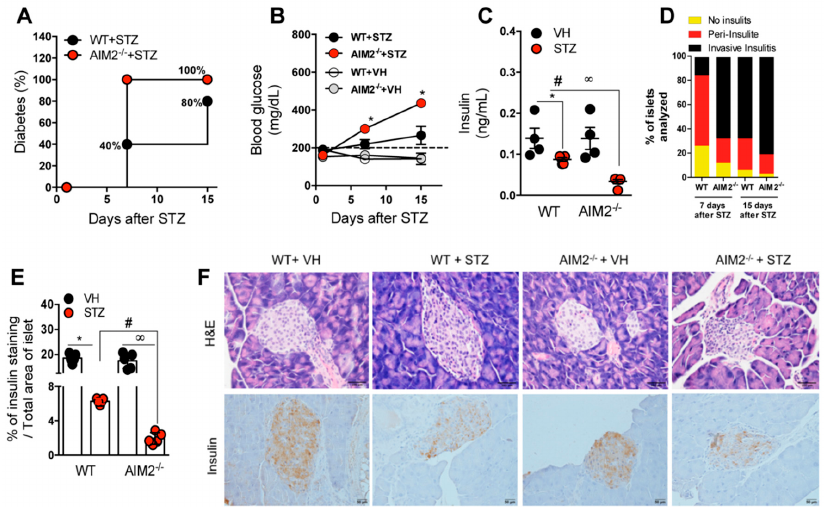
Figure 2. Deficiency of the AIM2 receptor accelerates Type 1 diabetes onset. The WT and AIM2 − / −